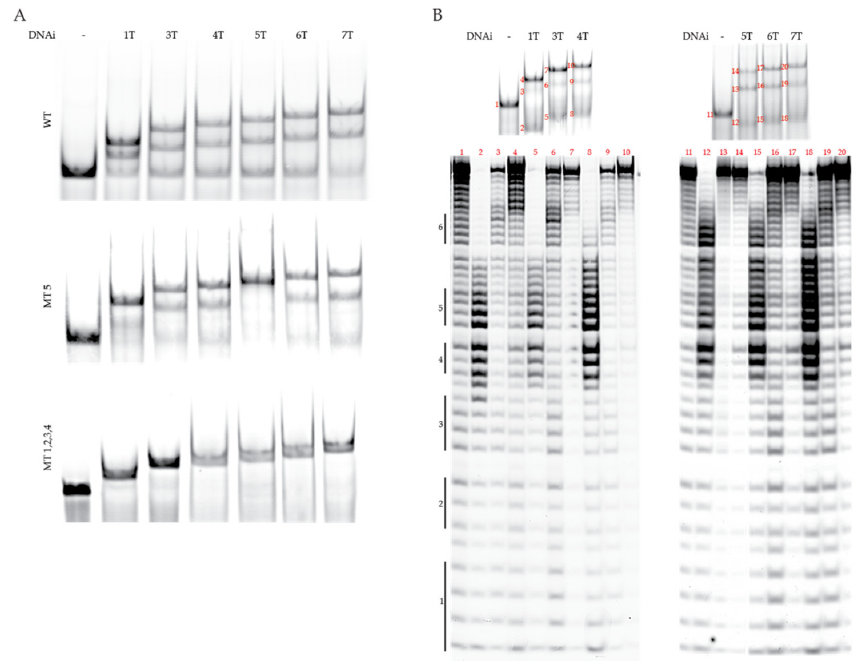
Figure 2. DNAi optimization for MYC G4 recognition. ( A ) Electromobility shift assays (EMSAs) were performed with the DNAi array with WT Pu46 DNA (top), G4 1-4 -forming MT 5 DNA (middle), and non-G4 forming MT 1,2,3,4 DNA (bottom). As determined in the development of clamp a [35], the supershifted (middle band) DNA represents the DNAi complementing the 5 ′ G4-flanking region, while the suprashifted (upper band) DNA represents a DNAi:MYC G4. ( B ) DMS footprinting clarifies the G:::G bonding of Pu46 with each DNAi, as isolated from each EMSA band. The six contiguous runs of continuous guanines within the Pu46 sequence are denoted to the left of the foot- prints. Linear DNA is noted in Bands 1–6, 8, 9, 11, 12, 15, 16, 18, and 19. G4 1-4 formation is evident in Bands 7, 10, and 14, indicated that DNAi 3T, 4T, and 5T can stabilize the physiologically relevant structure. A protection pattern ascribed to a mixture of G4 isoforms is noted in Bands 13, 17, and 20.